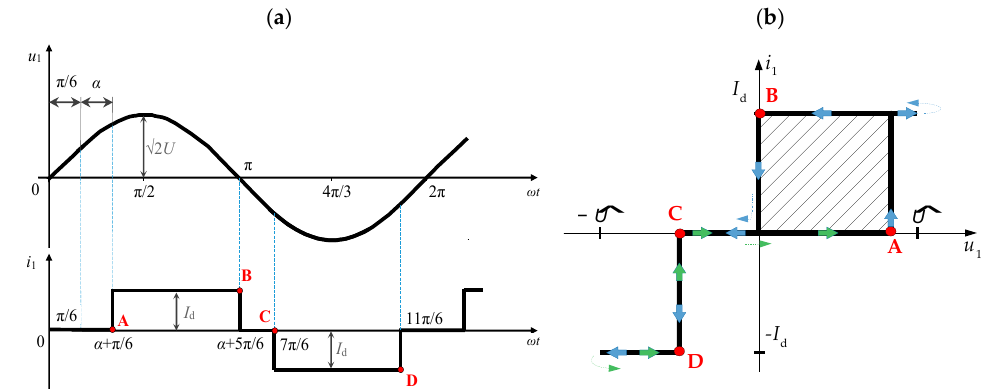
Figure 7. Typical waveforms of current and voltage ( a ) and u – i characteristic ( b ) of a semiconverter for 𝛼 < 60° .